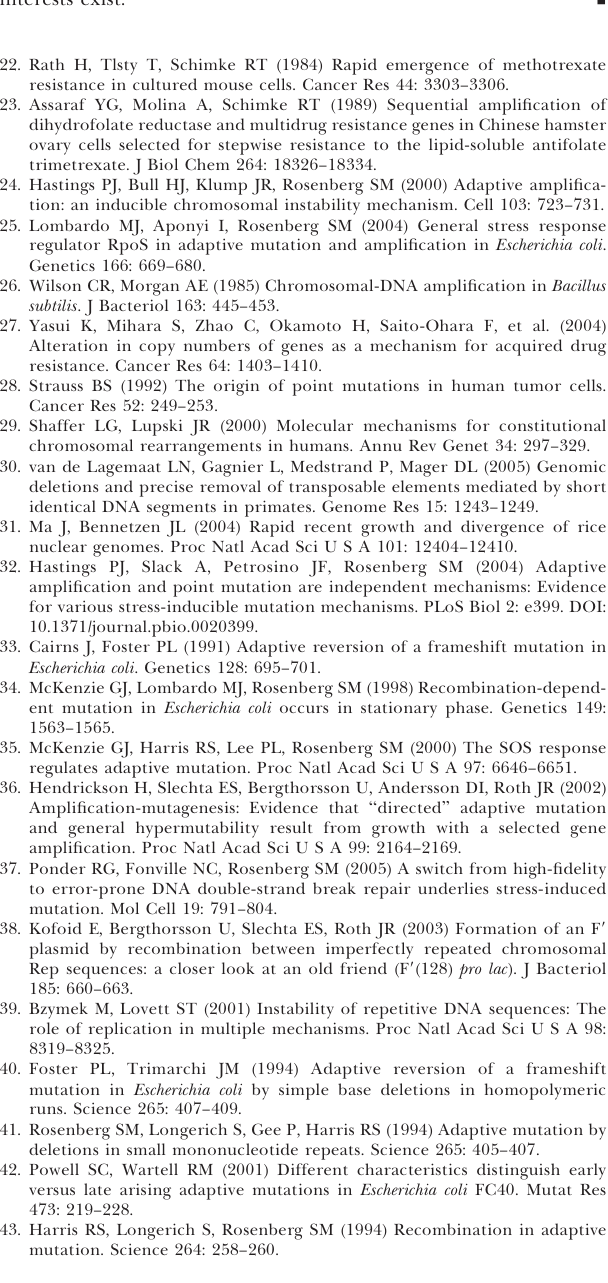
Table S1. Novel Junction Sequences in Their Contexts Found at DOI: 10.1371/journal.pgen.0020048.st001 (40 KB